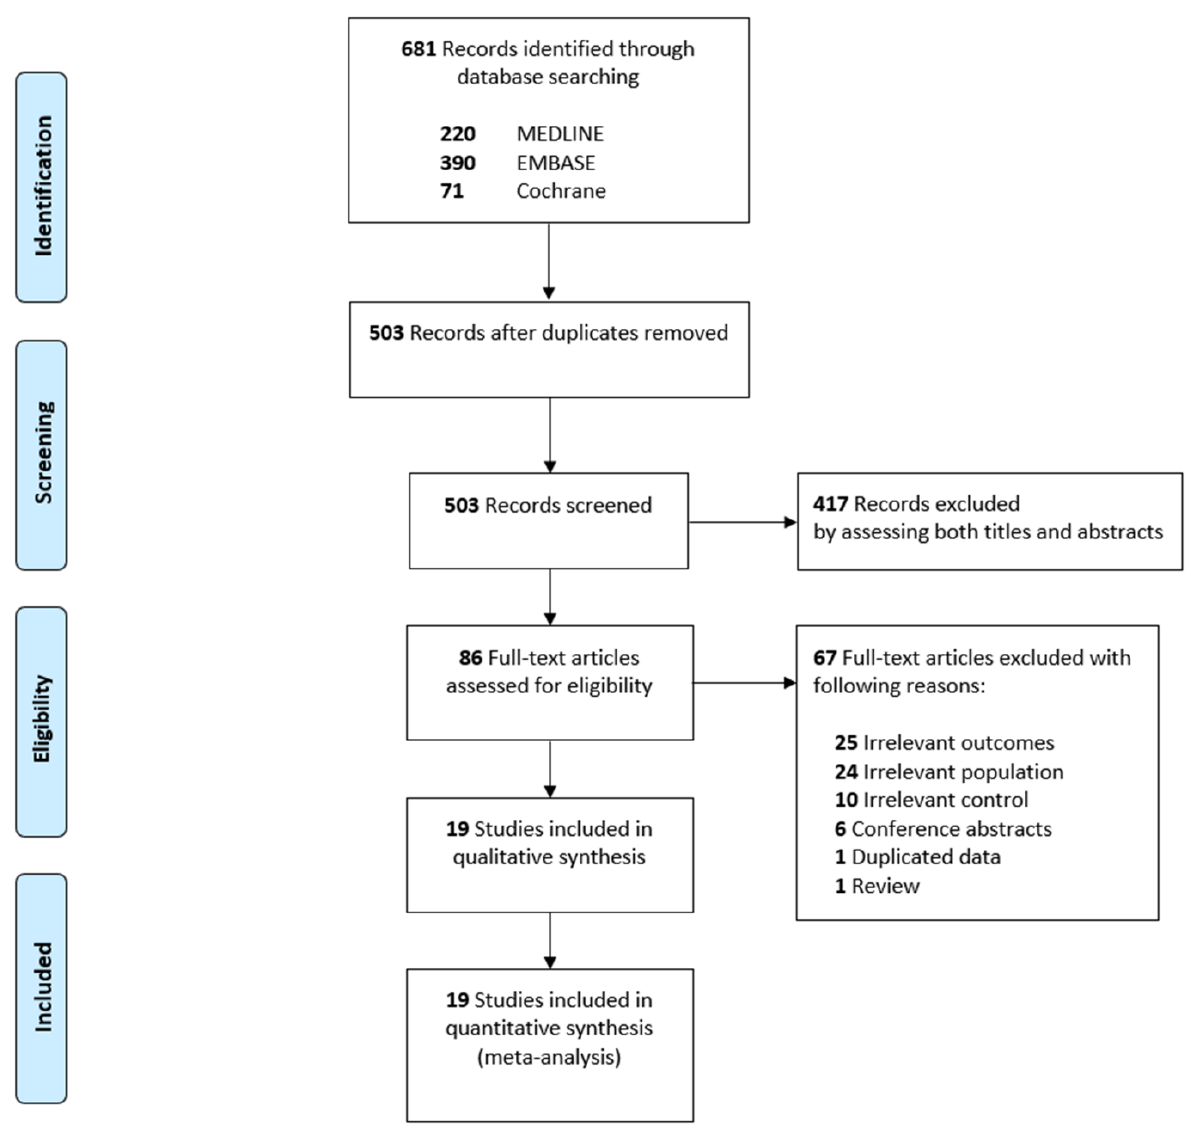
Figure 1. Flow diagram for the identification of relevant studies.